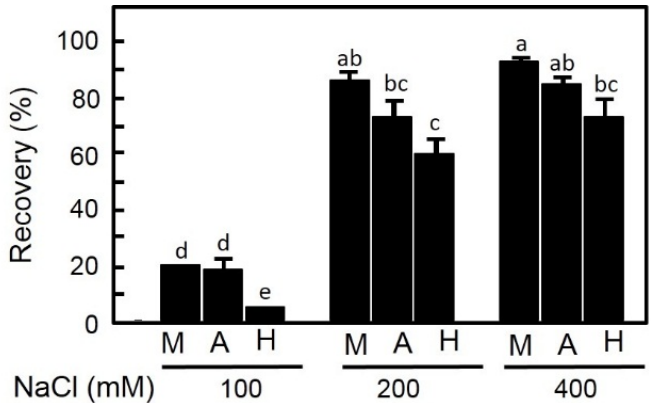
Figure 3. Germination rate index of Zygophyllum coccineum seeds from Manzala coast, Wadi Asyuti and Wadi Houf in distilled water, 100, 200 and 400 mM NaCl for 15 days. Value represents the mean of 3 replicates ± standard error. For variables denoted with the same letter, the di ff erence is not statistically significant.